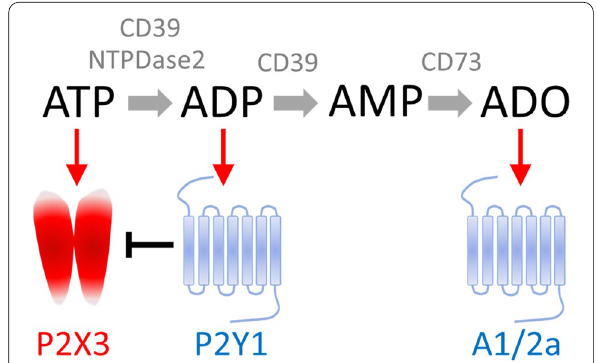
Fig. 1 ATP degradation and migraine relevant signalling via P2X3, ADP-specific P2Y1 and adenosine activated A1 and A2a receptors. Extracellular ATP is degraded by CD39 to ADP and AMP and the latter is transformed to adenosine (ADO) by CD73. In contrast to CD39, neuron-specific NTPDase2 generates ADP. ATP can activate neuronal P2X3 receptors selectively expressed in sensory neurons, whereas ADP activates metabotropic neuronal P2Y1 receptors (probably also the P2Y12/13 subtypes), which in turn depress P2X3 receptor activity, thus completing this regulatory loop. Adenosine activates either inhibitory A1 or excitatory A2a receptors. Red arrows indicate activation while the block stop line shows an inhibitory